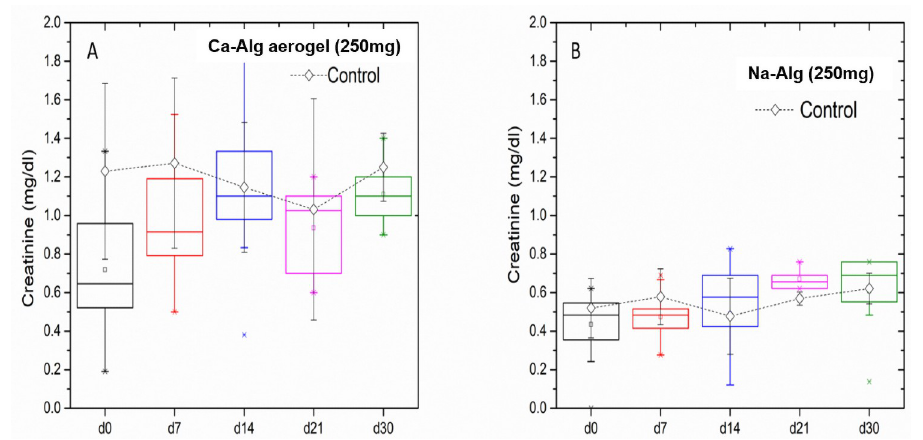
Fig 6. In vivo serum creatinine analysis, for the 250 mg Ca-Alg aerogels (A) and Na-Alg (B) during a long-term experiment.